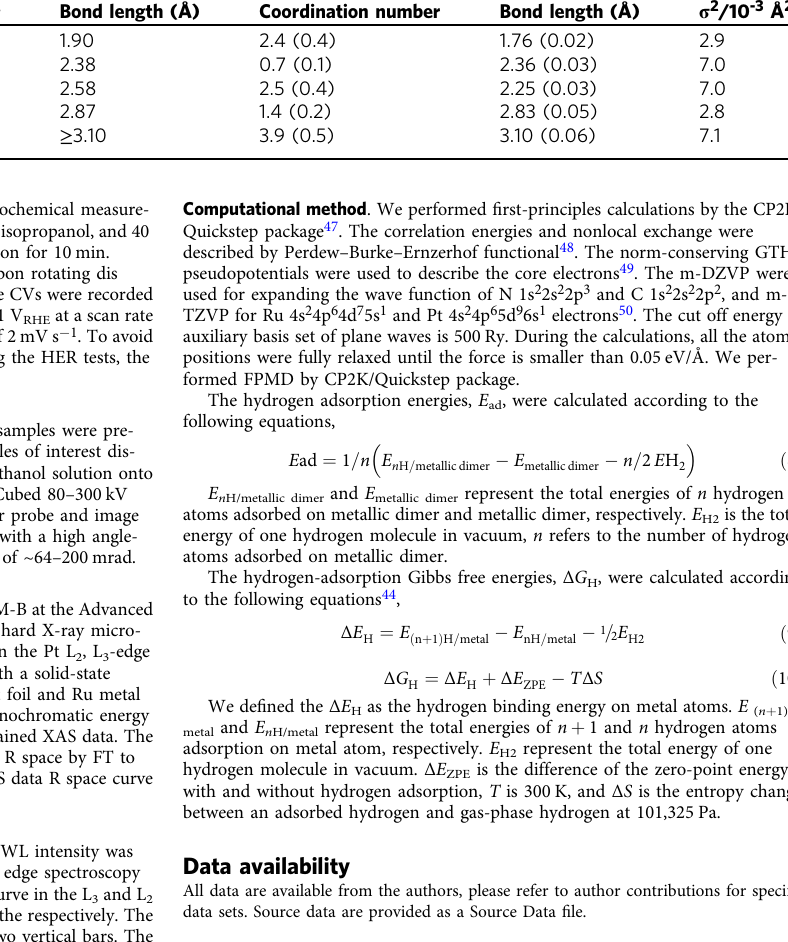
Table 3 R space fi tting results from Ru K edge for Pt – Ru dimers